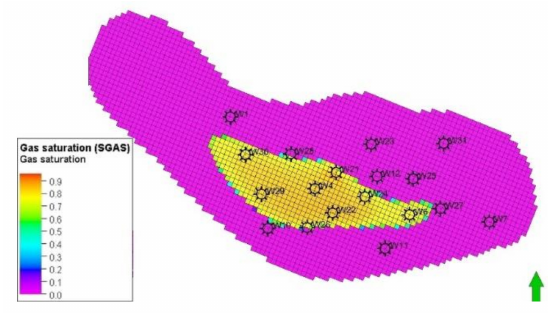
Figure 9. Initial gas saturation at the Rotliegend